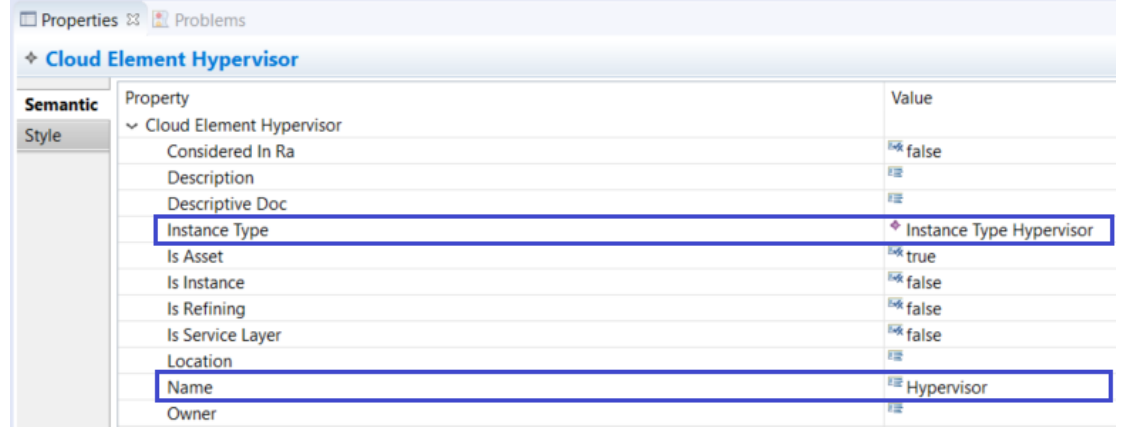
Figure 8. Equality of the name and instance type of an added cloud